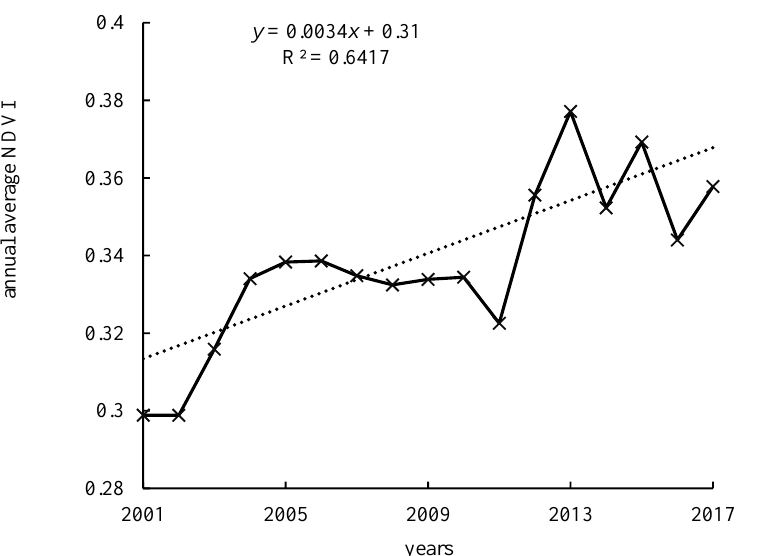
Figure 4. Annual average NDVI in the basin. Note: x = year − 2000.